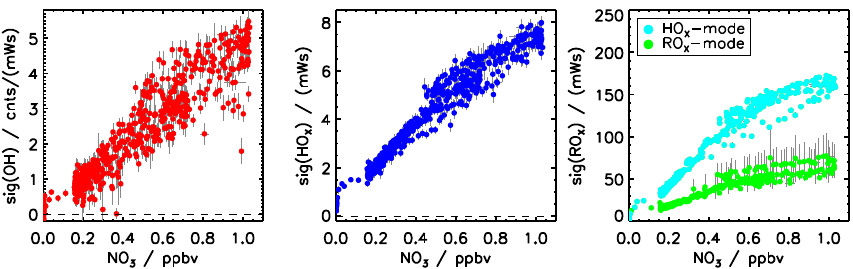
Figure 12. Correlation between count rates in the OH, HO x , and RO x cells (HO x and RO x mode in the case of the RO x cell) and measured NO 3 concentrations for the experiment shown in